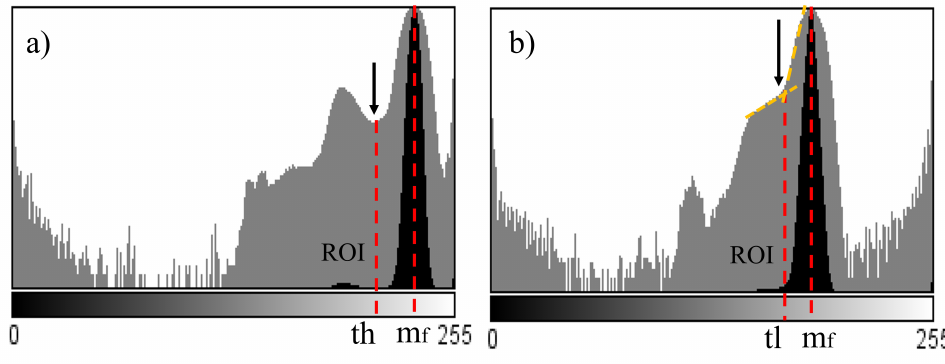
Figure 5. Histogram ( a ) bimodal, find the minimum point; ( b ) modal, find the change in slope.